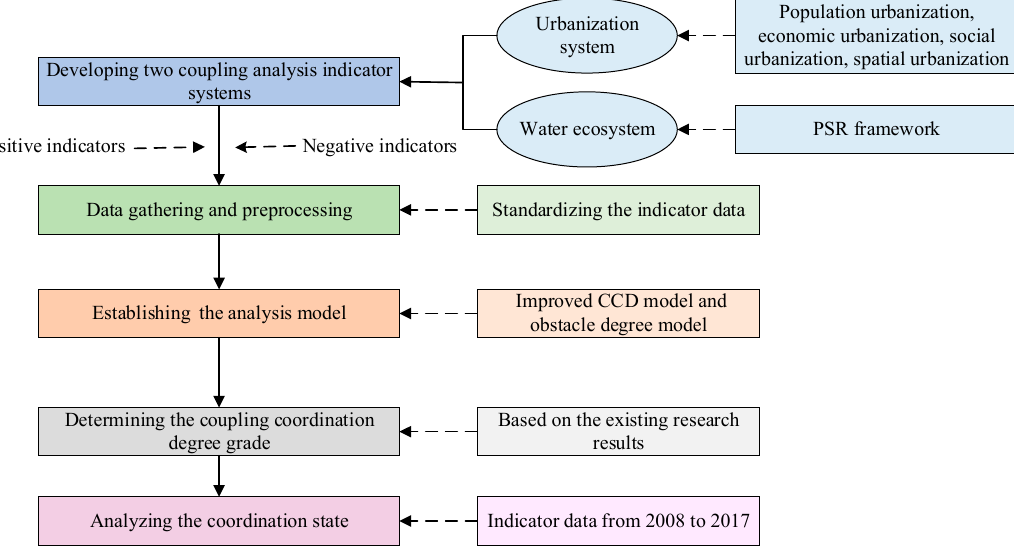
Figure 2. Framework of the methods in the coordination analysis among urbanization and water ecosystem (YREB, China).